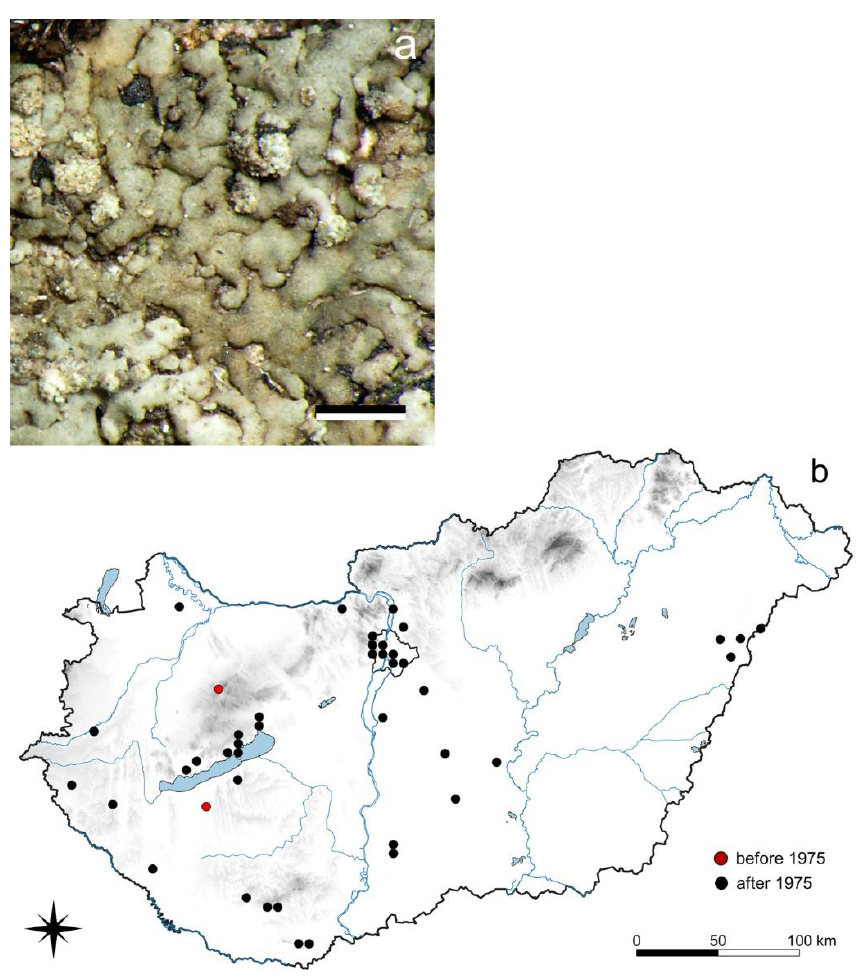
Figure 2. Hyperphyscia adglutinata ( a ) habit (scale 0.5 cm); ( b ) its distribution in Hungary (56 records). Dots represent c. 5 km × 6 km areas. ( Photo: L. Lőkös ).